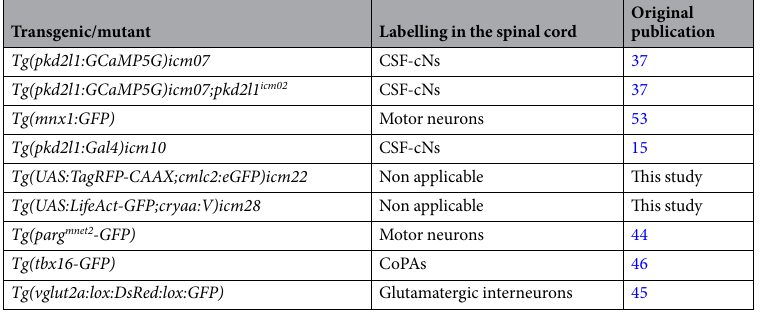
Table 1. Transgenic lines used in our